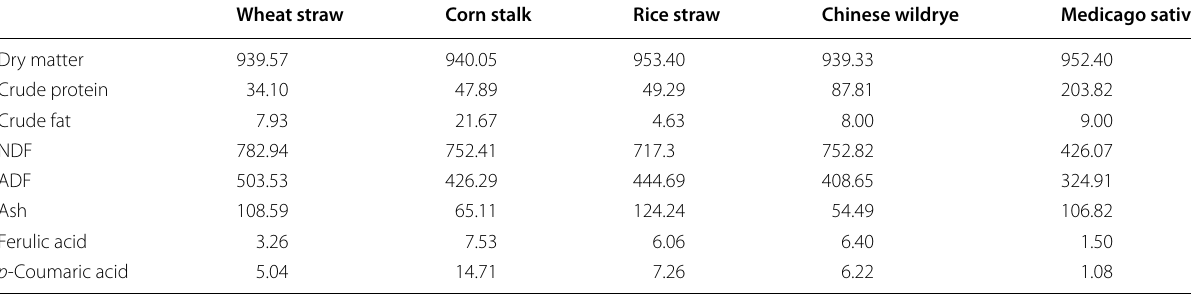
Table 1 Composition of the forages used as substrates before incubation (g/kg